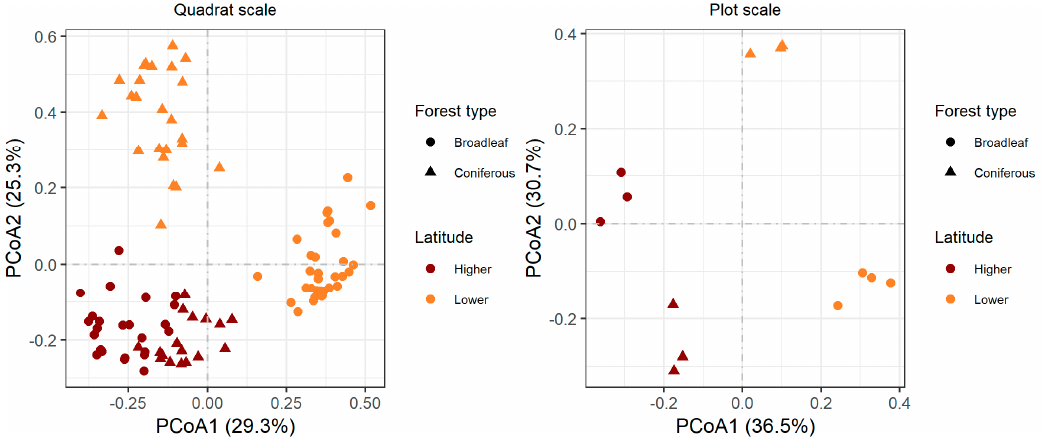
Figure 3. Ordination of understory plant communities under two forest types and two latitudes using principal coordinates analysis (PCoA). The distance matrix used in PCoA is based on the Sørensen dissimilarity index. The percentage of variation explained by each PCoA axis is in parentheses, and the first two axes accounted for 54.6% and 67.2% of total variation at the quadrat and plot scales,